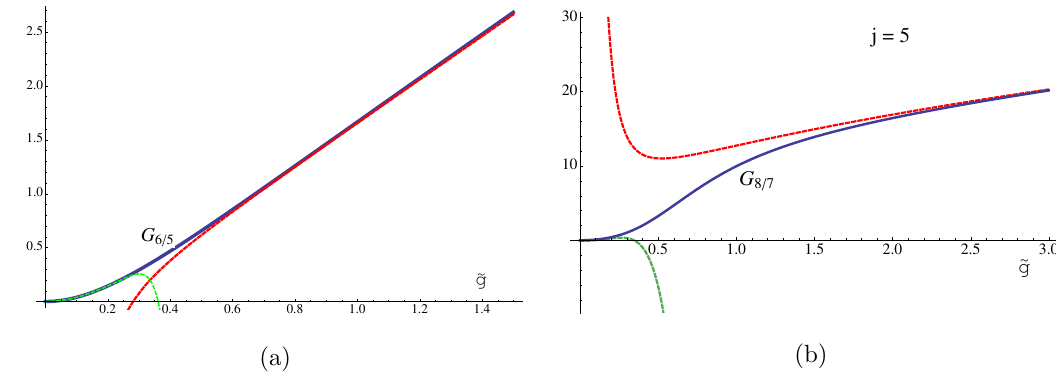
Figure 2. (a) The weak coupling expansion for the cusp is given by the Green dashed line and the strong coupling expansion is given by the Red dashed line. The interpolating function (cid:0) ( G 6 = 5 ) cusp is given by the solid Blue line. (b) The weak coupling expansion for the anomalous dimension at (cid:12)nite spin is given by the Green dashed line and the strong coupling expansion via QSC is given by the Red dashed line. The interpolating function G is given by the solid Blue 8 = 7